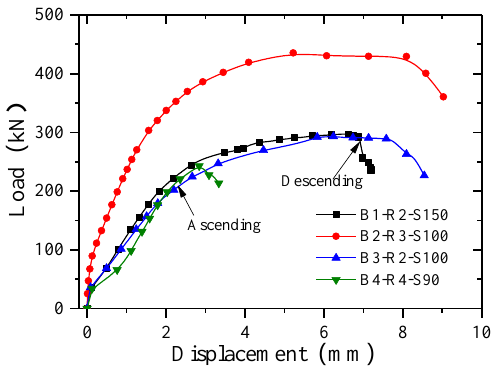
Figure 7. Load–slip curves for the bolt connections.